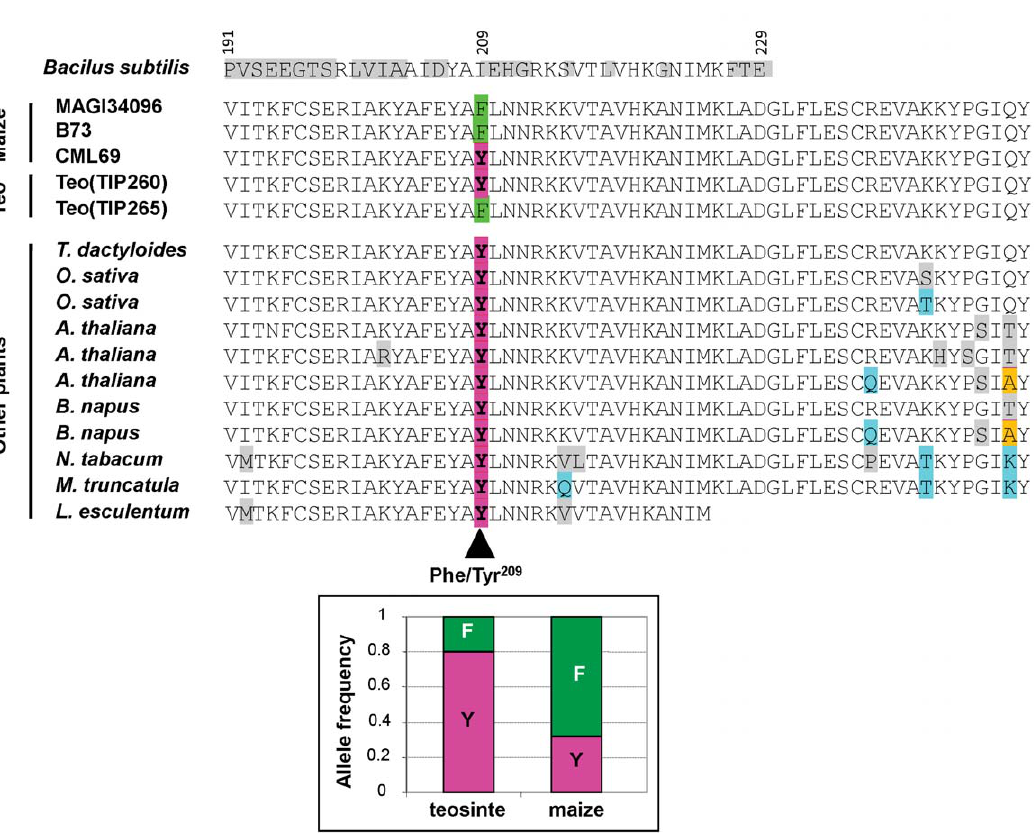
Figure 4. Conservation of Phe/Tyr 209 across related plant species and allele frequencies in maize and teosinte. ( A ) Protein sequence alignment of the part of IDH containing Phe/Tyr 209 SNP. ( B ) Comparison of allele frequencies at Phe/Tyr 209 between maize and teosinte. The teosinte sample contained 16 different accessions and the maize sample contained 267 inbred lines. P ( x 2 ) =0.004 for the comparison.